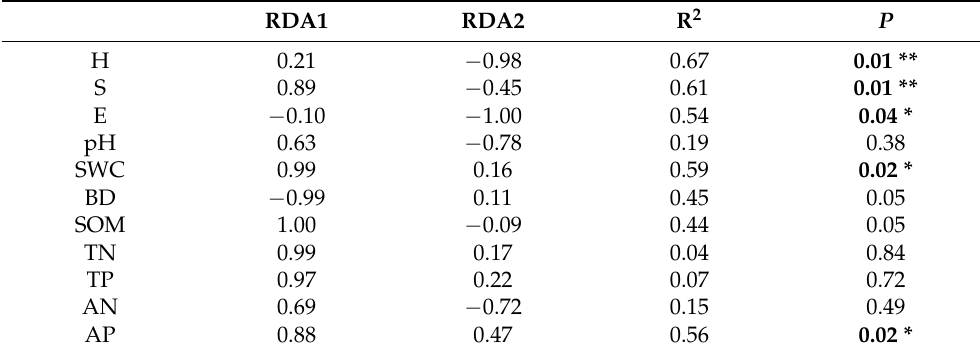
Table 5. Correlation between the redundancy analysis axes (RDA) of functional indices (FD and CWM) and influencing factors (soil properties and species diversity). RDA1